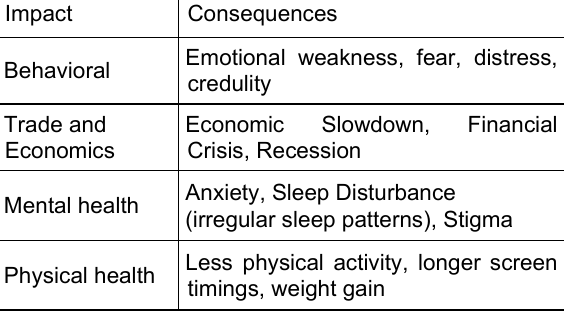
Table 3. Areas of Impact of Pandemic and their